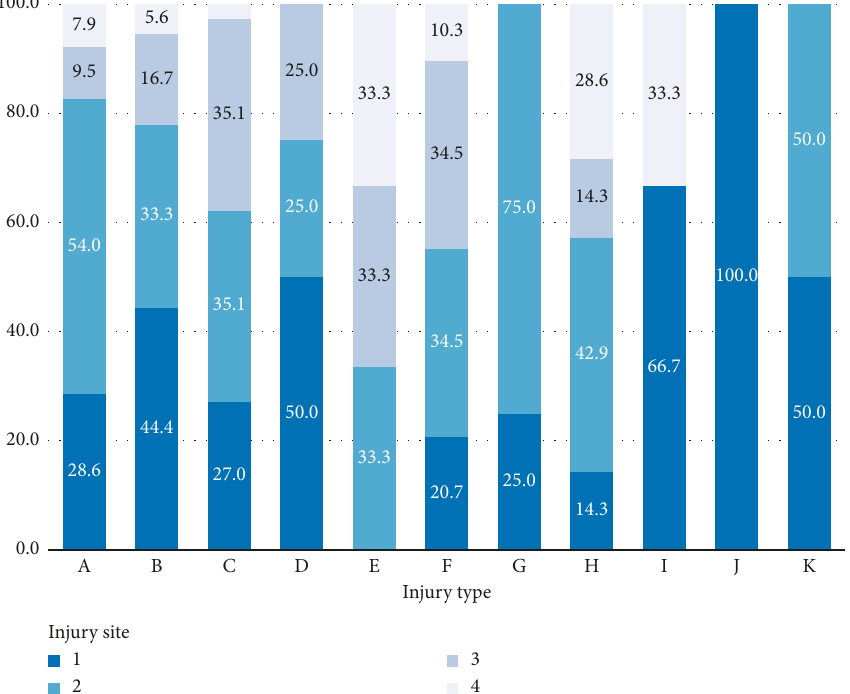
Figure 4: Proportion of abdominal angiography sites by trauma mechanisms. A, car accident; B, motorcycle accident; C, pedestrian accident; D, bicycle accident; E, ship or train accident; F, fall; G, slipping and rolling down; H, bumping injury; I, crush injury; J, explosion burn; K, others; 1, liver; 2, spleen; 3, pelvis; 4, others.